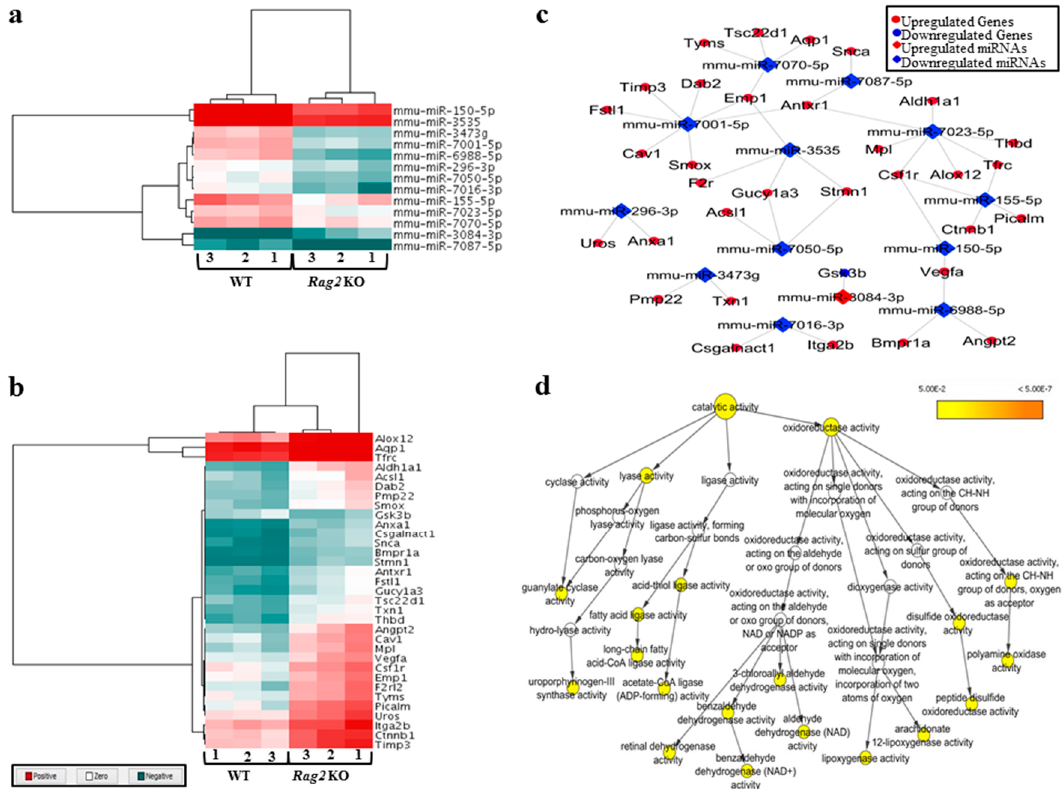
Figure 1. The figure showing deregulated miRNAs and their deregulated target genes in Rag2 knockout (KO) mice having involvement in catalytic activity. ( a ) Heatmap of the deregulated miRNAs in Rag2 KO mice which had deregulated targets; ( b ) Heatmap of the deregulated target genes of the deregulated miRNAs in Rag2 KO mice; ( c ) The interaction network showing the connection between deregulated miRNAs and deregulated target genes in Rag2 KO mice; ( d ) The catalytic activity network showing the involvement of the deregulated target genes of the deregulated miRNAs in different catalytic processes.